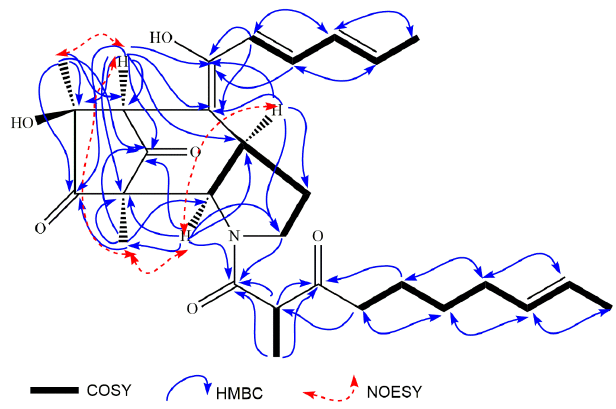
Figure 2. The key COSY, HMBC and NOESY correlations of penicitroamide ( 1 ).